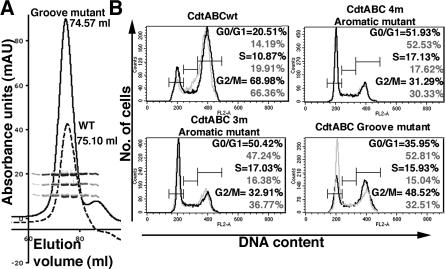
Effect of the Aromatic Patch and Groove Mutants on the Holotoxin Assembly and Toxicity(A) Elution profile of the wild-type and groove mutant of the CDT holotoxin during size exclusion chromatography. Samples were loaded on a Superdex 200 HiLoad 16/60 column at a flow rate of 2 ml/min in 200 mM NaCl, 20 mM HEPES (pH 7.5), 2.5 mM DTT on ÄKTA FPLC. Peak fractions (2 ml) were analyzed by SDS-PAGE (15% gel), and CDT subunits were visualized with Coomassie blue staining. SDS-PAGE of the CDT holotoxin groove mutant is shown inside gel filtration chromatogram. Elution volumes of wild-type and mutant holotoxin are shown.(B) Cell cycle analysis of HeLa cells exposed to 1 ng/ml (gray) or 10 ng/ml (black) concentration of either wild-type or mutant holotoxin for 3 hr at 37 °C, 5% CO2. Cells were processed 48 hr after holotoxin treatment, and DNA content was measured by flow cytometry, as detailed in Materials and Methods. The calculate percentages of cells in G0/G1, S, and G2/M are shown. CdtABC 4m Aromatic mutant (CdtA: W91G/W98G/W100G/Y102A); CdtABC 3m Aromatic mutant (CdtA: W98G/W100G/Y102A); CdtABC groove mutant (CdtA: P103A/Y106A, CdtC: R43K/Q49A).